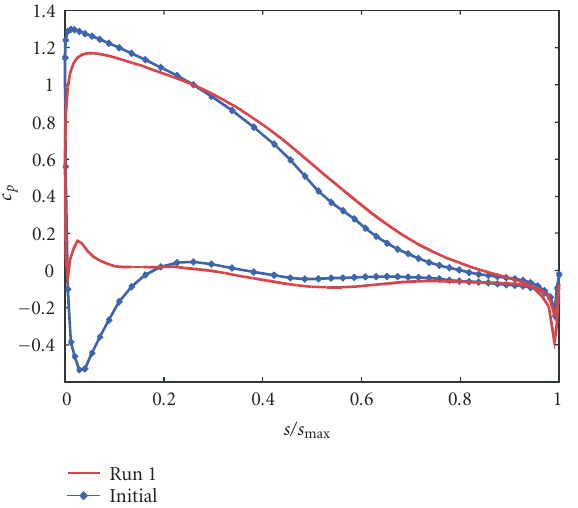
Figure 9: Blade angle distribution of the runner blade for the initial design and the first optimization